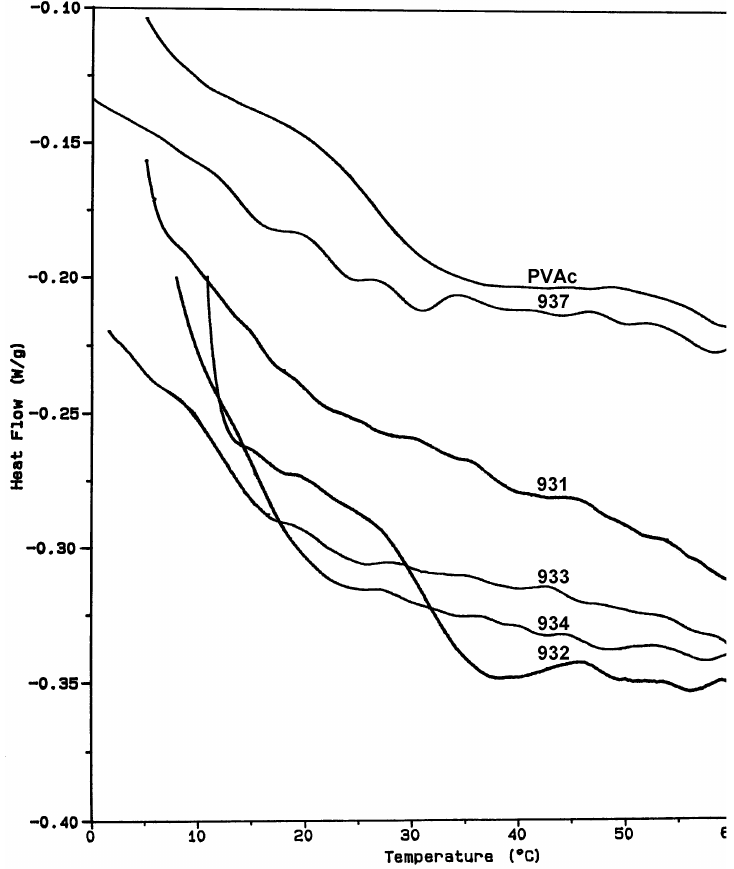
Fig. 6 DSC diagram of hybrids from PVAc (s.931: PVAc+TIP; s.932: PVAc+TIP+MPTS; s.933: PVAc+TIP+MeTES; s.934: PVAc+TIP+OTES; s.937: